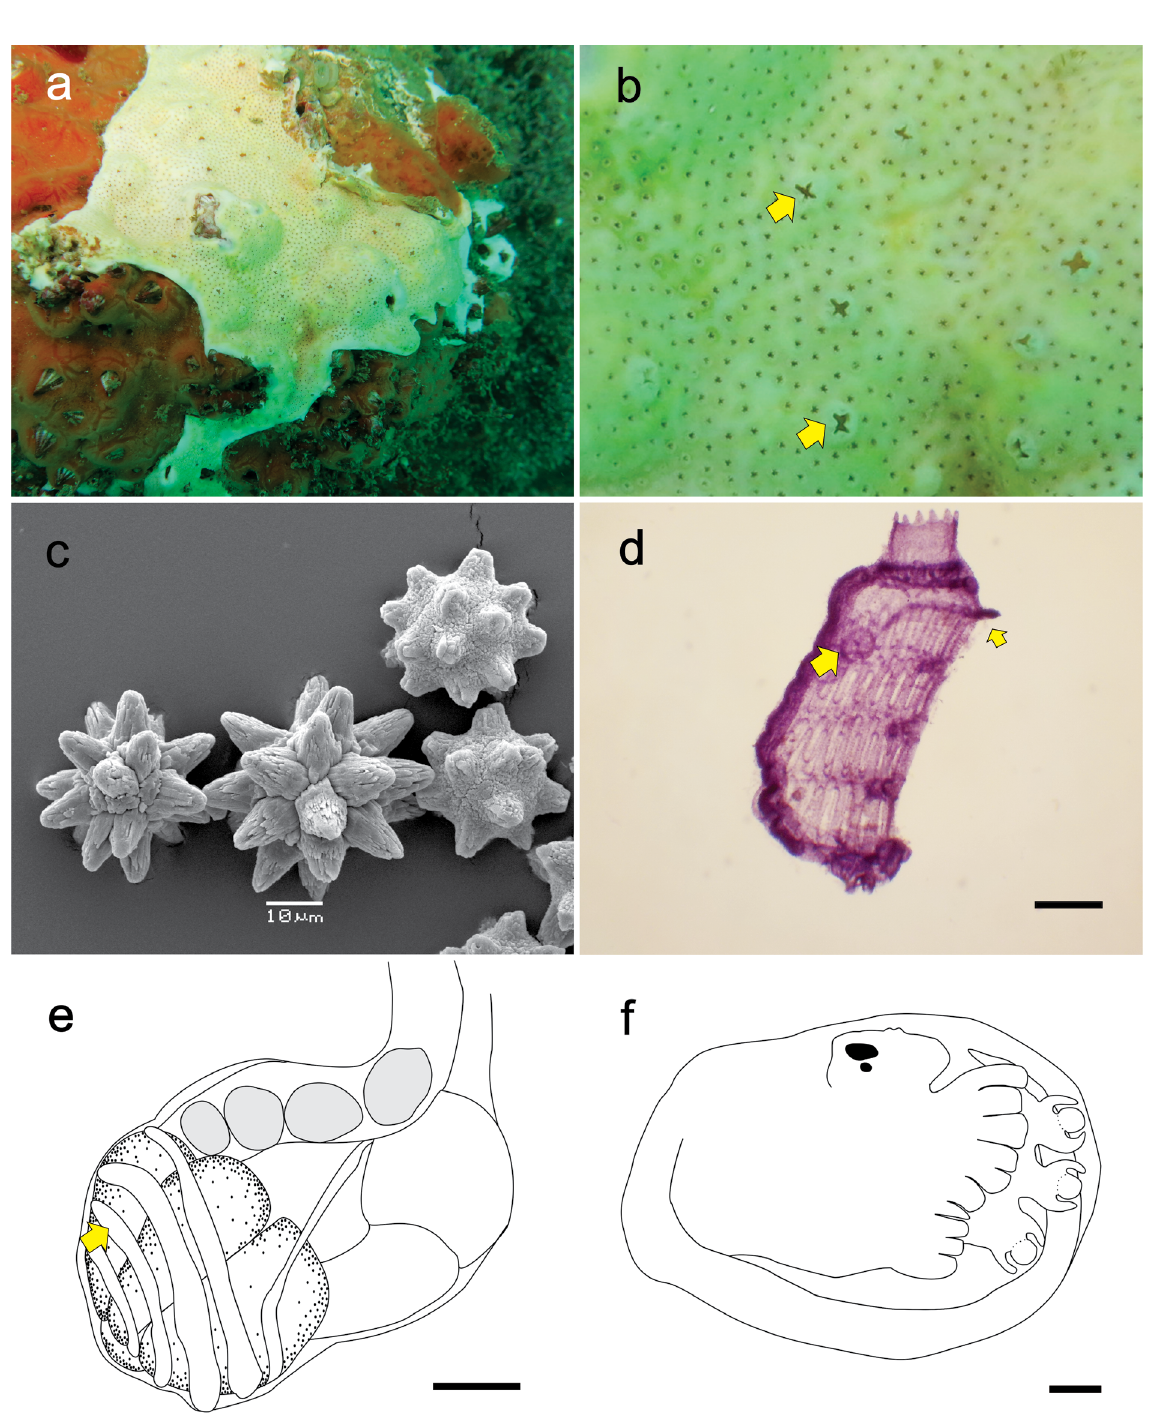
Fig. 6. Polysyncraton cabofriense Oliveira & Rocha sp. nov. (DZUP POSC-50). a . Colony in situ . b . Colony surface (arrows indicating common cloacal apertures with lobes). c . Spicules. d . Thorax stained (big arrow indicating the lateral thoracic organ and small arrow the atrial languet). e . Abdomen (arrow indicating the sperm duct coil). f . Larva. Scale bars: d–f = 0.1 mm. Photo (a) courtesy of L.S.